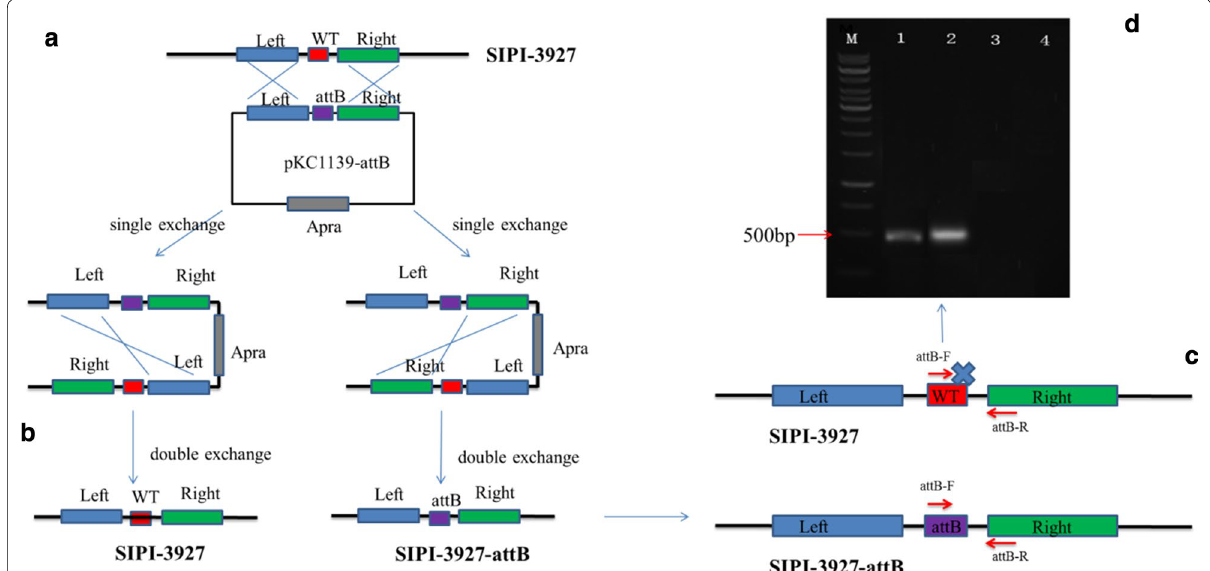
Fig. 2 Homologous recombination to construct SIPI‑3927‑ attB strain containing attB site. a Single exchange screening of recombinant strains containing apramycin resistance. b Double exchange screening of recombinant strains with loss of apramycin resistance. c , d PCR amplification results of double exchange strains. M, maker; 1–2, double‑exchange strain containing attB site; 3, double‑exchange strain without attB site; 4, parent